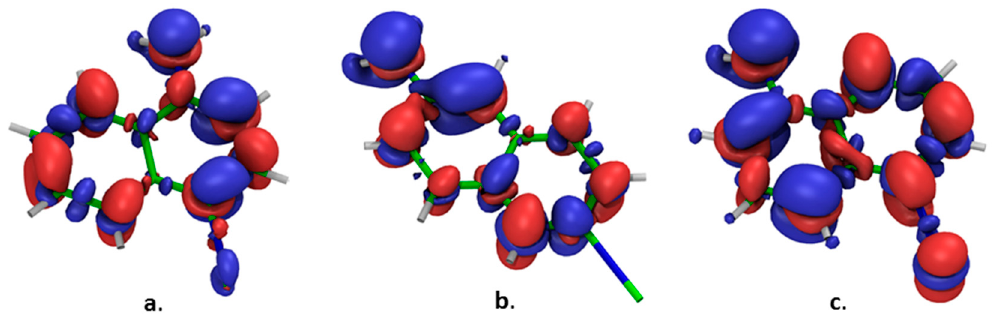
Figure 2. Calculated electronic density differences between the first vertical excited state and the ground state in DMSO for the 1,4-ICAN ( a ), 2,6-ICAN ( b ), and 1,5-ICAN ( c ) isomers.